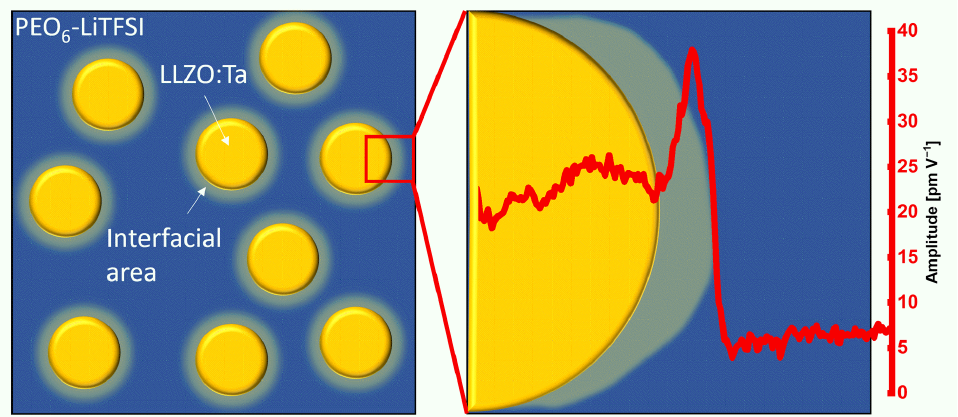
Figure 8. Schematic illustration of the bulk polymer phase with several ceramic particles and a segment of a single particle with the ESM amplitude line section of Figure 6. The interfacial area shown is not to